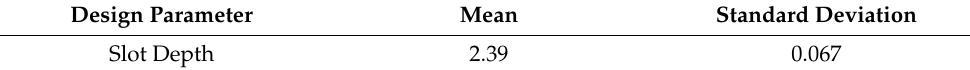
Table 11. Mean and standard deviation for the design parameters.